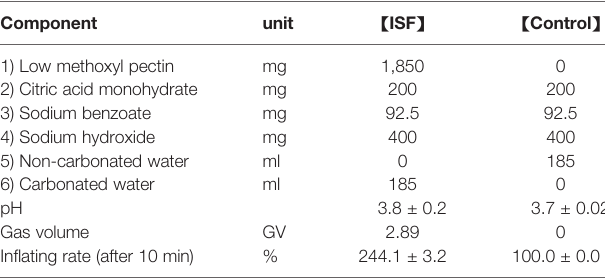
TABLE 1 | Composition of ISF (in fl ating stomach formulation) and control solution (Control) and results of in fl ating rate of these solutions in vitro .